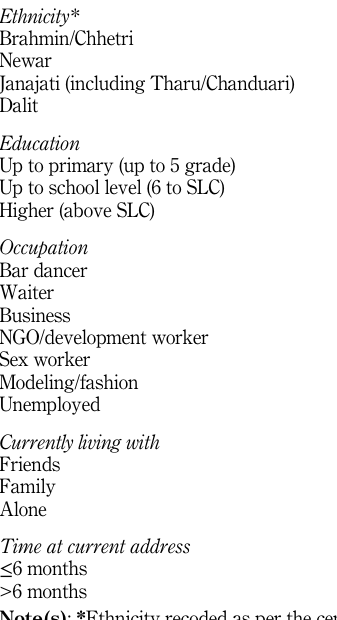
Table 2. Characteristics of